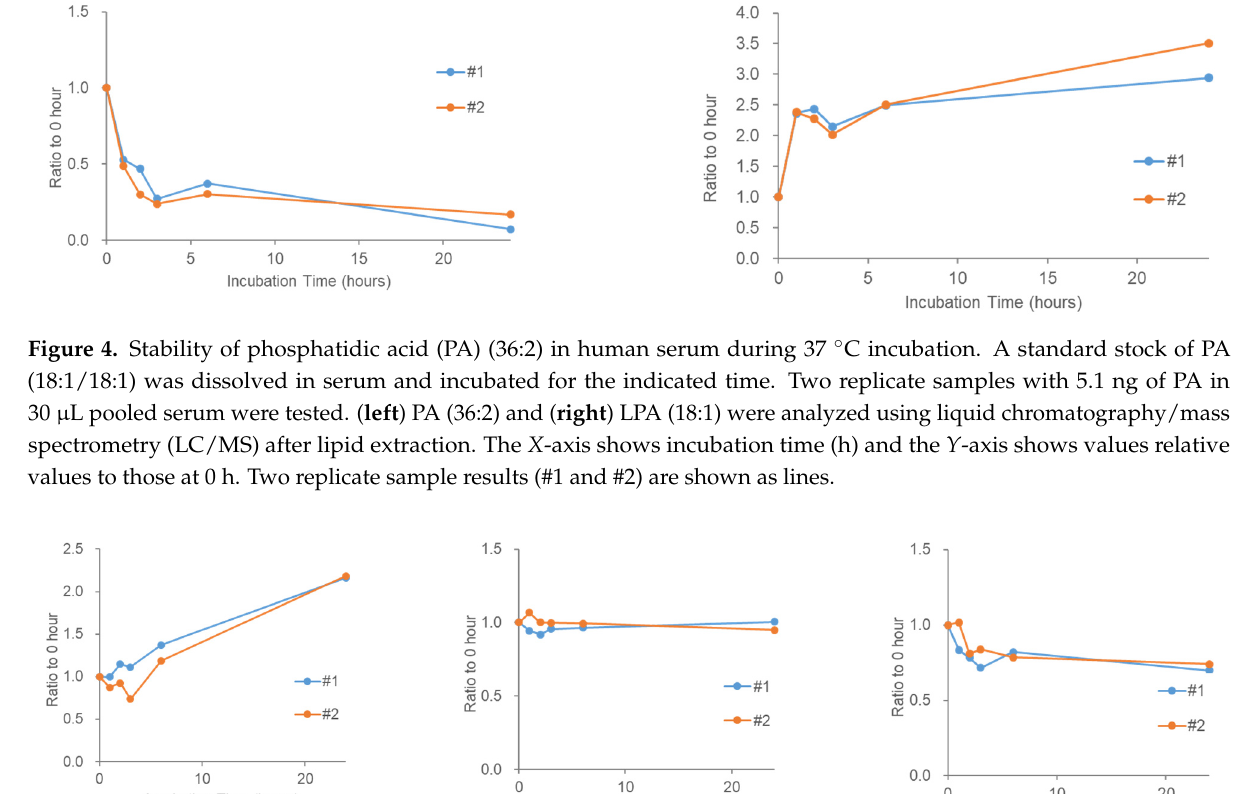
Table 2. Demographic characteristics of patients.